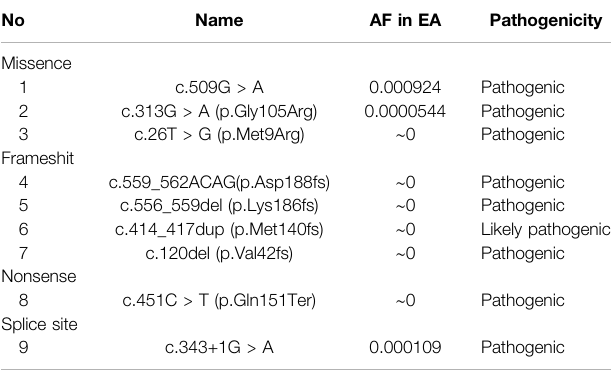
TABLE3| ReportedP/LPvariantsindatabaseandtheirallelefrequencyinEastern